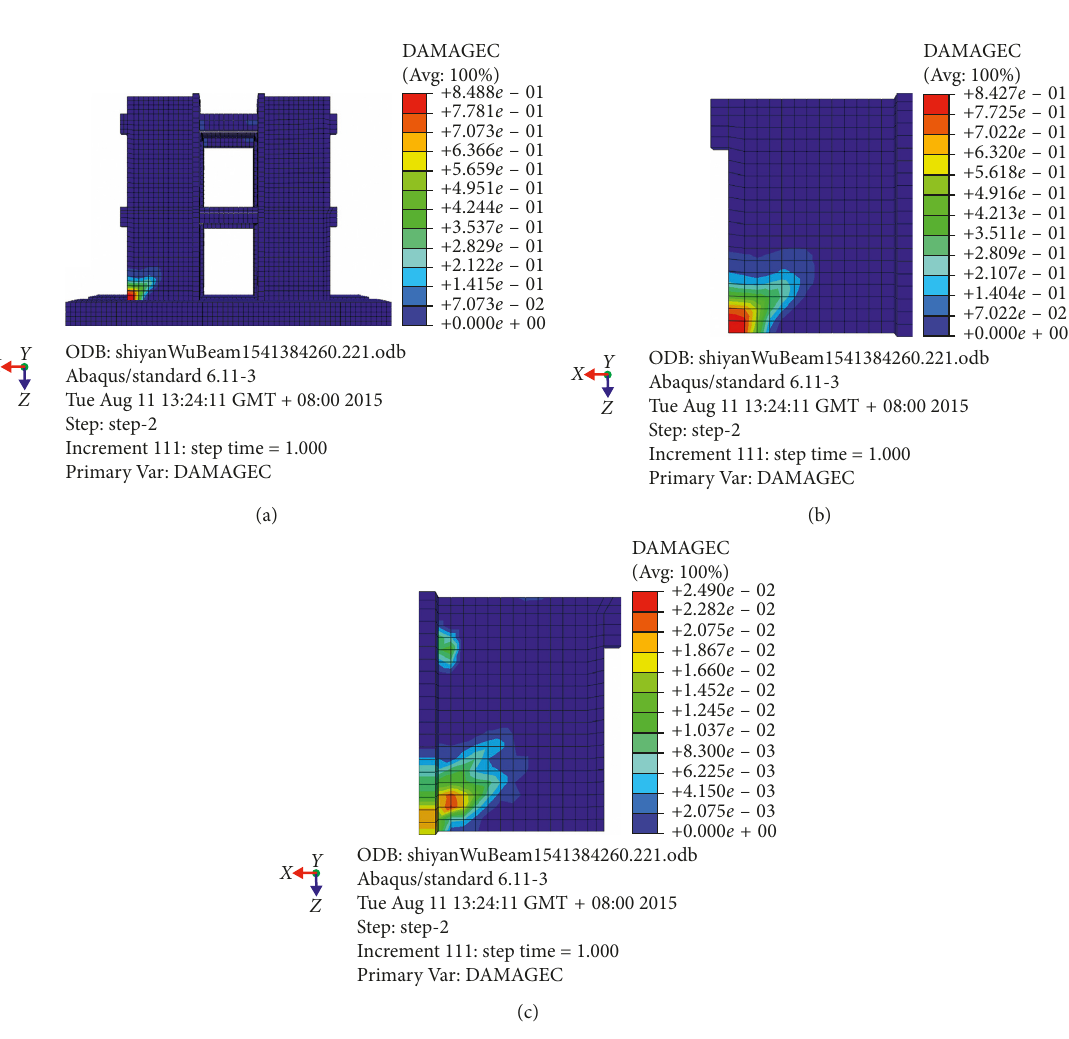
Figure 19: Concrete compressive damage ratio distribution of the NPGCS spatial model. (a) Concrete compressive damage ratio dis- tribution of the whole NPGCS spatial model. (b) Concrete compressive damage ratio distribution on 1st floor web compressive panel of the whole NPGCS spatial model. (c) Concrete compressive damage ratio distribution on 1st floor flange compressive panel of the whole NPGCS spatial